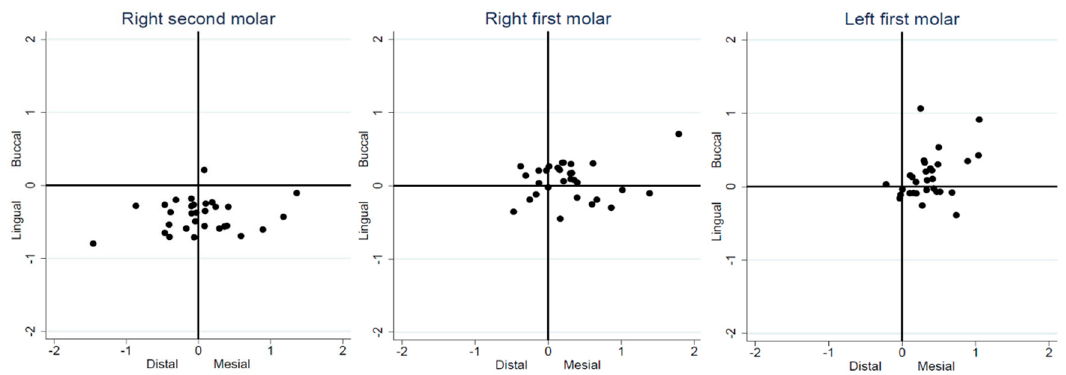
Figure 7. The distributions of the lateral deviations at the implant platform of every dentist in each implant site group.